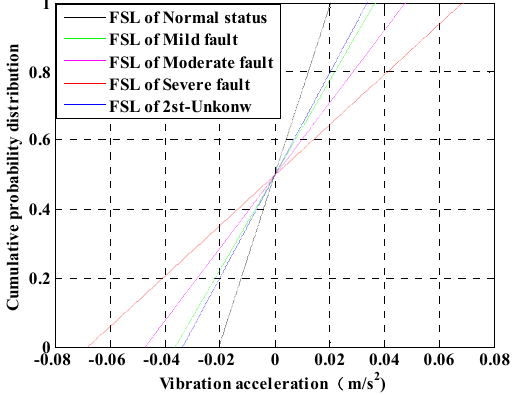
Figure 8. The second transformer's vibration signal cumulative probability distribution curve FSL comparison diagram.